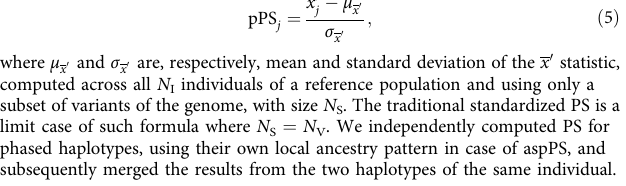
Fig. 7. We then measured R 2 on speci fi c sample sets by predicting their phenotypes with the model fi tted above and assessed standard deviation through 5000